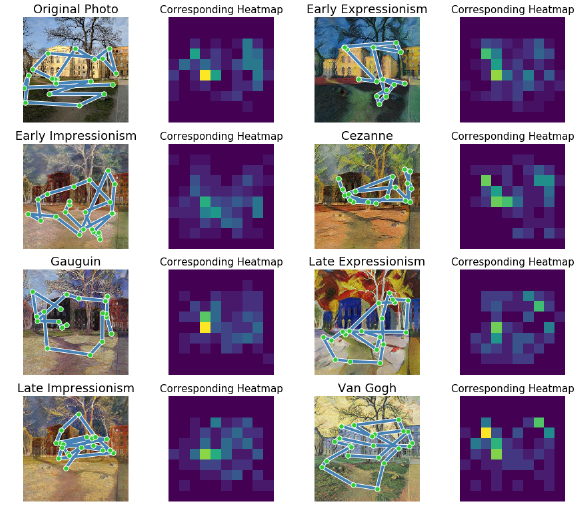
Figure 12. One photograph and its transformations in all seven art styles with the corresponding eye-tracking data. Columns 1 and 3 show the stimuli with a gaze path of one example subject.